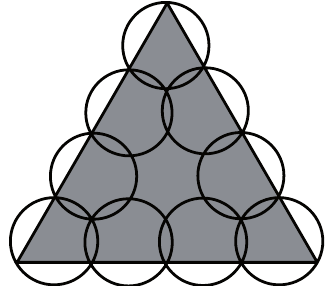
Fig. 7. Equilateral triangle component approximated with 9 circles.